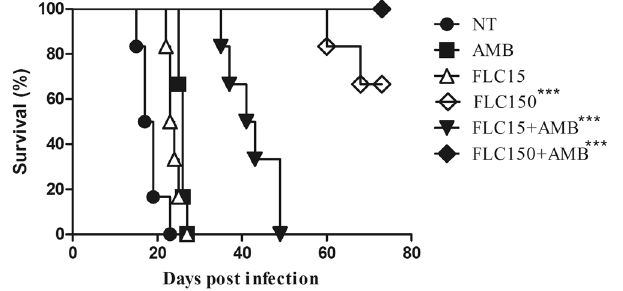
Figure 1. Six mice per group were inoculated by the intratracheal route with 1 × 10 6 cells of L27/01 cryptococcal cells. Fluconazole (15 or 150 mg/kg/day) and amphotericin B (0.5 mg/kg/day) alone or in combination were administered intraperitoneally (i.p.) from one day post-infection. Animals were monitored daily for the survival curve. All treatments significantly prolonged the median survival of mice infected. Treatment with 150 mg/kg/day fluconazole alone or in combination with amphotericin B and 15 mg/kg/day fluconazole in combination with amphotericin B improved the median survival of mice treated with antifungals in monotherapy. NI (not infected); NT (Control, untreated), AMB (Amphotericin B 0.5 mg/kg/day), FLC15 (Fluconazole 15 mg/kg/day), FLC150 (Fluconazole 150 mg/kg/day) FLC15 + AMB (Fluconazole 15 mg/kg/ day + Amphotericin B 0.5 mg/kg/day), FLC150 + AMB (Fluconazole 150 mg/kg/day + Amphotericin B 0.5 mg/ kg/day). *** P < 0.001 (compared with the NT